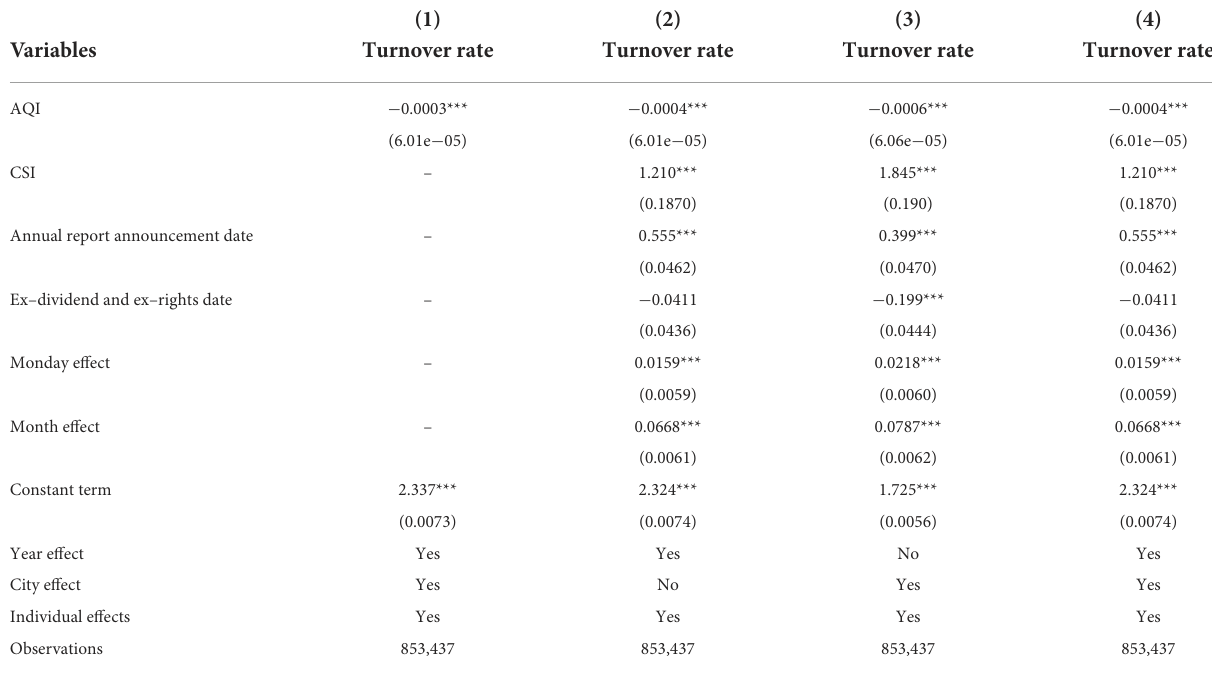
TABLE 2 Baseline regression of turnover rate and air